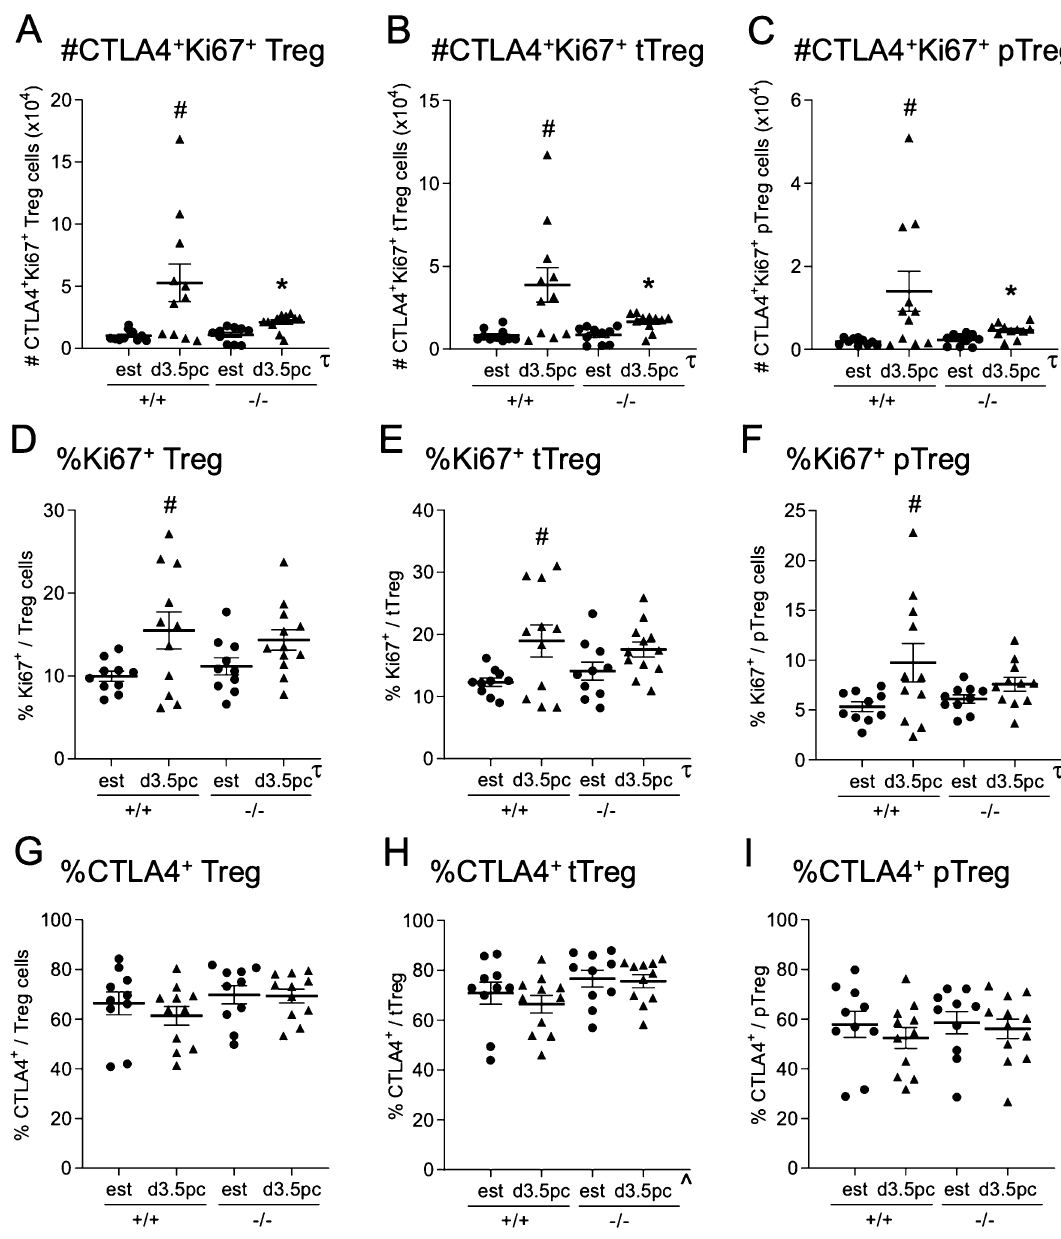
Figure 5. Effect of maternal TLR4 deficiency on expression of CTLA and Ki67 by Treg cells in the uterine dLN after mating. Cells harvested from the dLN of Tlr4 + / + (+/+) and Tlr4 −/− (−/−) mice at estrus, or on d 3.5 pc after mating with B6 males, were analyzed by flow cytometry to assess expression of the suppressive marker CTLA4 and proliferation marker Ki67 in Treg cells (defined as CD4 + CD25 + FOXP3 + ) and tTreg (NRP1 + Treg) and pTreg (NRP1 − Treg) cells. The total number of double positive CTLA4 + Ki67 + Treg ( A ), NRP1 + tTreg ( B ) and NRP1 − tTreg ( C ) cells was quantified. The proportion of Ki67 + cells within the total Treg ( D ), NRP1 + pTreg ( E ) and NRP1 − tTreg ( F ) cell populations, and the proportion of CTLA4 + cells within the total Treg ( G ), NRP1 + pTreg ( H ) and NRP1 − tTreg ( I ) cell populations, was determined. Symbols depict individual mice (n = 10–17/ group) and data are shown as mean ± SEM. Differences between groups were assessed by one-way ANOVA with Sidak t test (* p < 0.05 between genotype of the same mating status, # p < 0.05 between estrus and mating within a genotype). The overall effect of genotype and mating was assessed by two-way ANOVA (τ p < 0.05 difference attributable to mating; ^ p < 0.05 difference attributable to